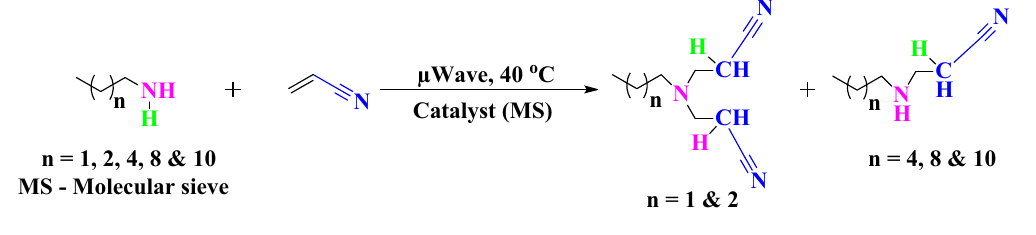
Figure 1. Synthetic route for acrylonitrile adducts.